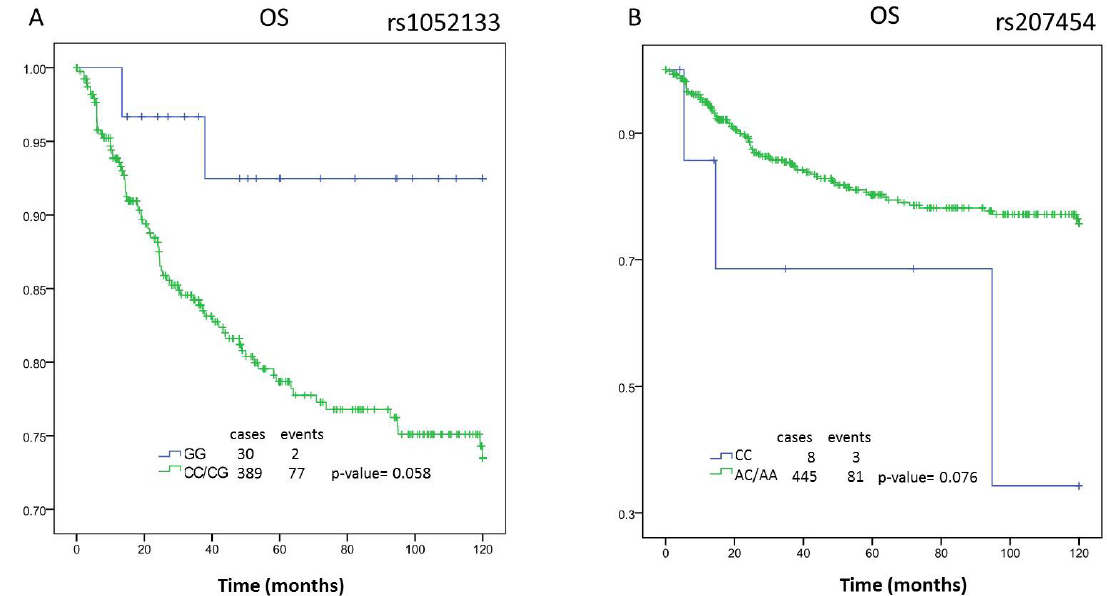
Figure 1. Kaplan-Meier analysis of rs1052133 and rs207454 polymorphisms. A and B : overall survival (OS) of total patients in function of the polymorphisms rs1052133 and rs207454,